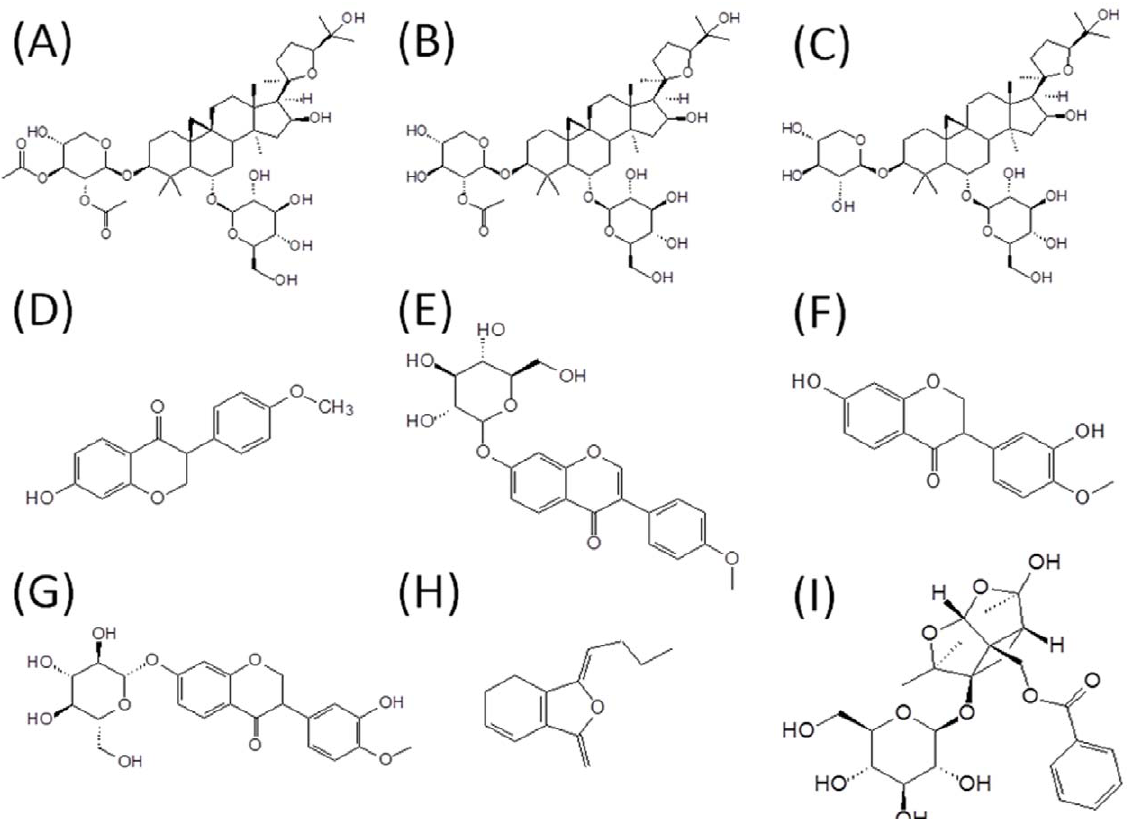
Figure 1. Structure formula of 9 components in bu-yang-huan-wu-tang extract of astragaloside I (A), astragaloside II (B), astragaloside IV (C), formononetin (D), ononin (E), calycosin (F), calycosin-7-O- b -D-glucoside (G), ligustilide (H) and paeoniflorin (I).